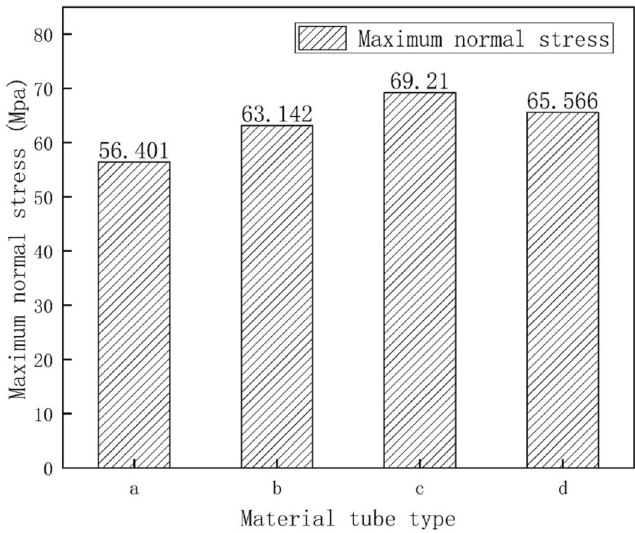
Figure 11. Normal skeleton stress under uneven snow load condition: ( a ) round tube; ( b ) square tube; ( c ) Ω tube; ( d ) elliptic tube.